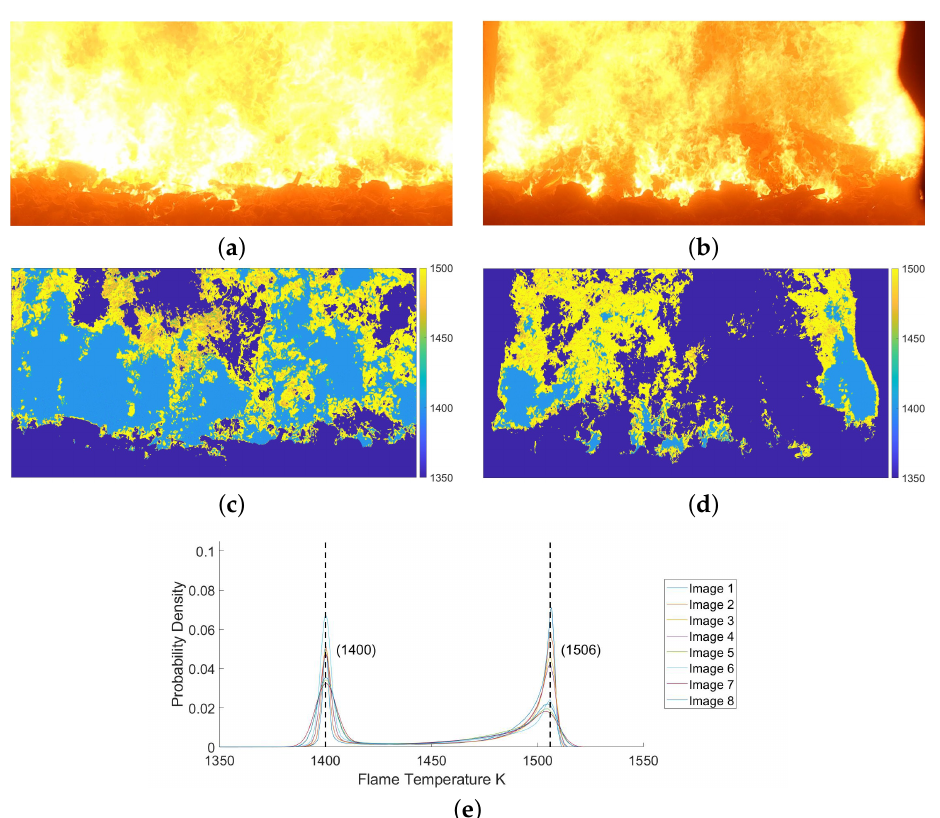
Figure 6. Furnace images of the same MSW incinerator taken from different angles. ( a ) Flame image 1; ( b ) Flame image 2; ( c ) Flame thermal image 1; ( d ) Flame thermal image 2; ( e ) The temperature probability density distribution of the whole